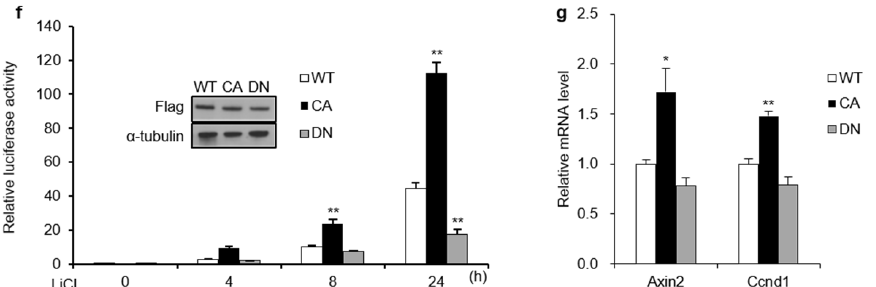
Figure 3. S6K1 regulates Wnt/ β -catenin-mediated transcription. ( a ) Reduced S6K1 affects cyclin D1 protein expression. Immunoblotting was performed using 293T cells with stable S6K1 knockdown (293T-S6K1 KD) treated with LiCl (25 mM) for 8 h. ( b ) Reduced S6K1 suppresses TOPFlash luciferase reporter activity. The TOPFlash luciferase reporter assay was performed using 293T cells treated with LiCl for the indicated time points after transient transfection with S6K1 siRNA (48 h). ( c ) Reduced S6K1 suppresses β -catenin transcriptional activity. qRT-PCR was performed using 293T cells treated with LiCl for 8 h after transient transfection with S6K1 siRNA (48 h). ( d ) S6K1 inhibition suppresses TOPFlash luciferase reporter activity. The TOPFlash luciferase reporter assay was performed using 293T cells treated with LiCl for the indicated time points after pretreatment for 1 h with rapamycin (25 nM) and PF-4708671 (10 µ M). ( e ) S6K1 inhibition suppresses β -catenin transcriptional activity. qRT-PCR was performed using 293T cells treated with LiCl for 8 h after pretreatment for 1 h with rapamycin (25 nM) and PF-4708671 (10 µ M). ( f ) TOPFlash luciferase reporter activity is regulated by S6K1 in a kinase activity-dependent manner. The TOPFlash luciferase reporter assay was performed using 293T cells stably expressing Flag-tagged WT, CA, and DN forms of S6K1 treated with LiCl (25 mM) for the indicated time points. ( g ) Kinase activity of S6K1 affects β -catenin transcriptional activity. qRT-PCR was performed using 293T cells stably expressing Flag-tagged WT, CA, and DN forms of S6K1 treated with LiCl (25 mM) for 8 h. Data are presented as the mean ± SEM for n = 3. * p < 0.05; ** p < 0.01; *** p <